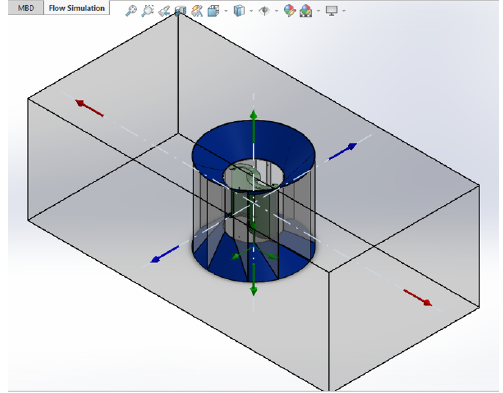
Figure A2. Configuration of the computational domain.